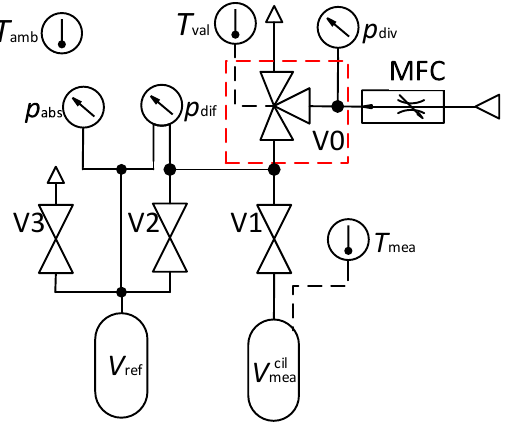
Figure 3. Schematic of a system without control signals. Diverter (V0) in red box.